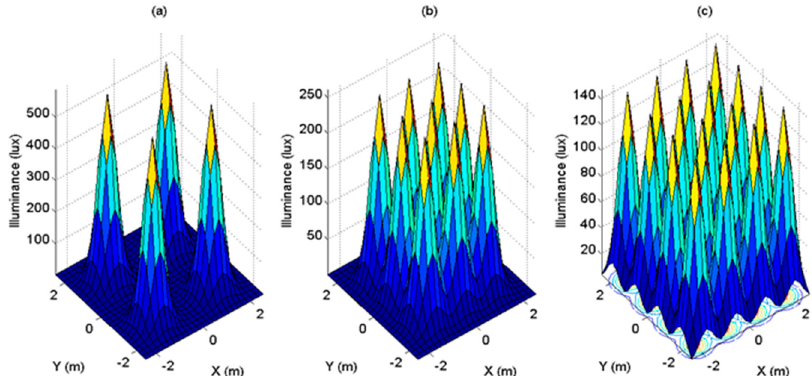
Figure 5. Illuminance (lux) at ∅ 1/2 = 10 ◦ ( a ) the case of 4 arrays, ( b ) the case of 9 arrays, and ( c ) the case of 16 arrays.